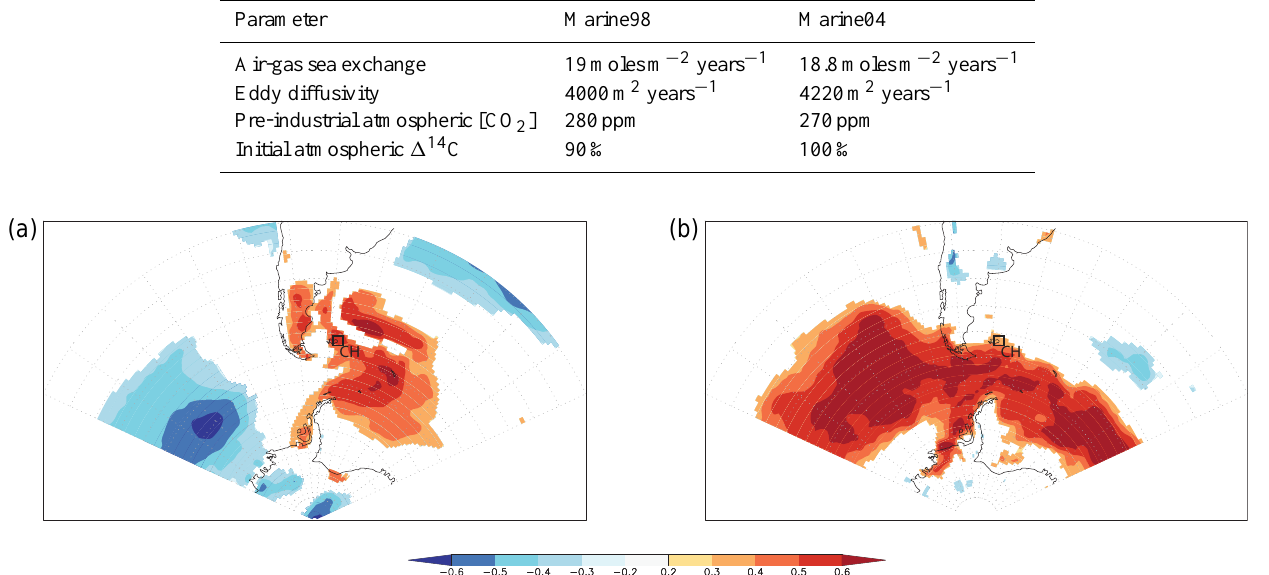
Figure 4. Correlation of relationship between the hemispherically averaged Southern Annular Mode (SAM) index (Marshall, 2003) with 2–10m air temperature (a) and wind strength (b) in the ERA-79 Interim reanalysis (Dee et al., 2011) (July–June, 1979–2013). Location of Canopus Hill, (CH), Falkland Islands, shown. Analyses were made with KNMI Climate Explorer (van Oldenborgh and Burgers,